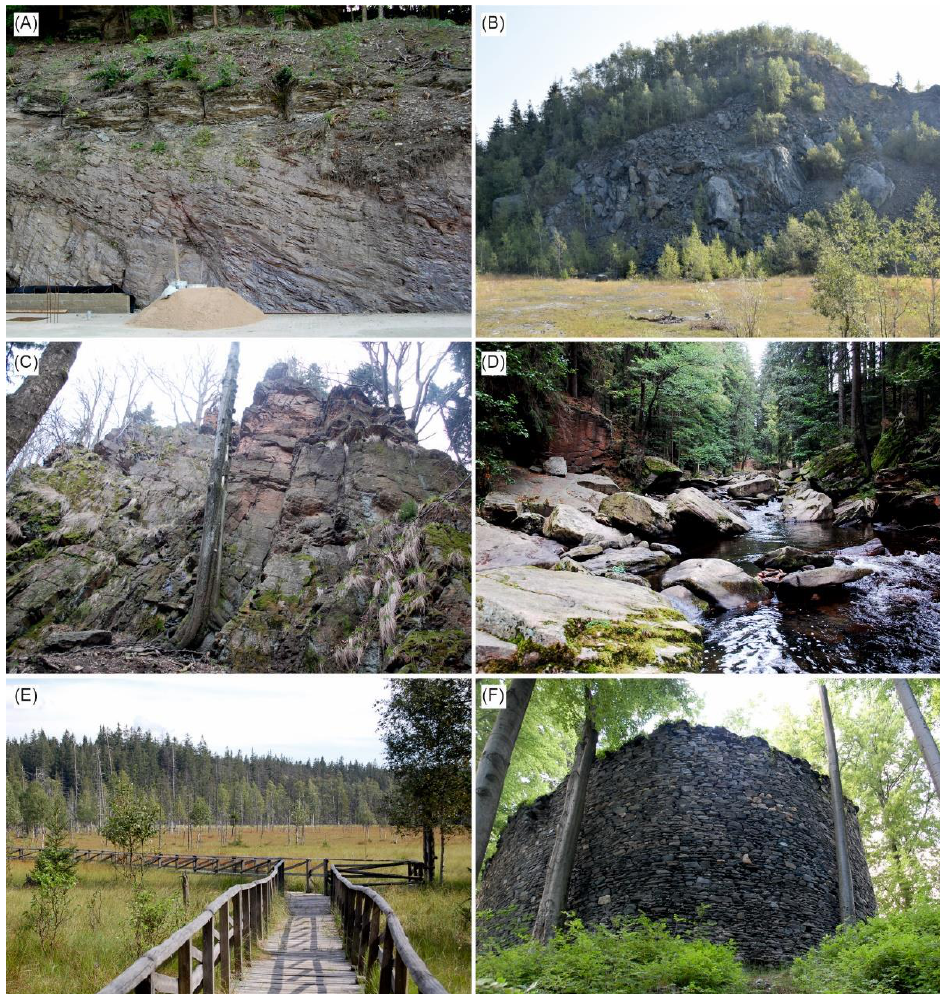
Figure 3. Selected geosites in the Orlické–Bystrzyckie Mountains Block, included in the respective inventories on the Czech [54] and Polish [55] side of the area. ( A ) Rock outcrop to show transgressive Cretaceous marine deposits lying unconformably on the Palaeozoic basement (site no. 6; Table 1); ( B ) abandoned gabbrodiotite quarry (site no. 7; Table 1); ( C ) gneissic crags (site no. 25; Table 1); ( D ) bedrock channel in fluvial gorge (site no. 24; Table 1); ( E ) peat bog (site no. 34; Table 2); ( F ) ruins of a castle built from local stone material (site no. 45; Table 2).